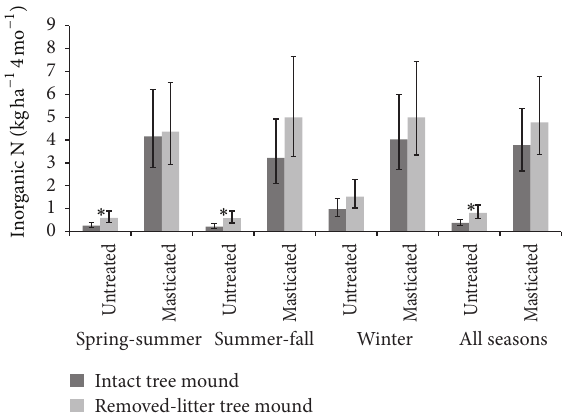
Figure 4: Tree mound effects on inorganic N (NO 3− + NH 4+ ) derived from ion exchange membranes. Asterisks indicate dif- ferences between column pairs ( 𝑃 < 0.01 ). Winter includes November–February, spring-summer includes March–June, and summer-fall includes July–October. Error bars are 95% confidence intervals.